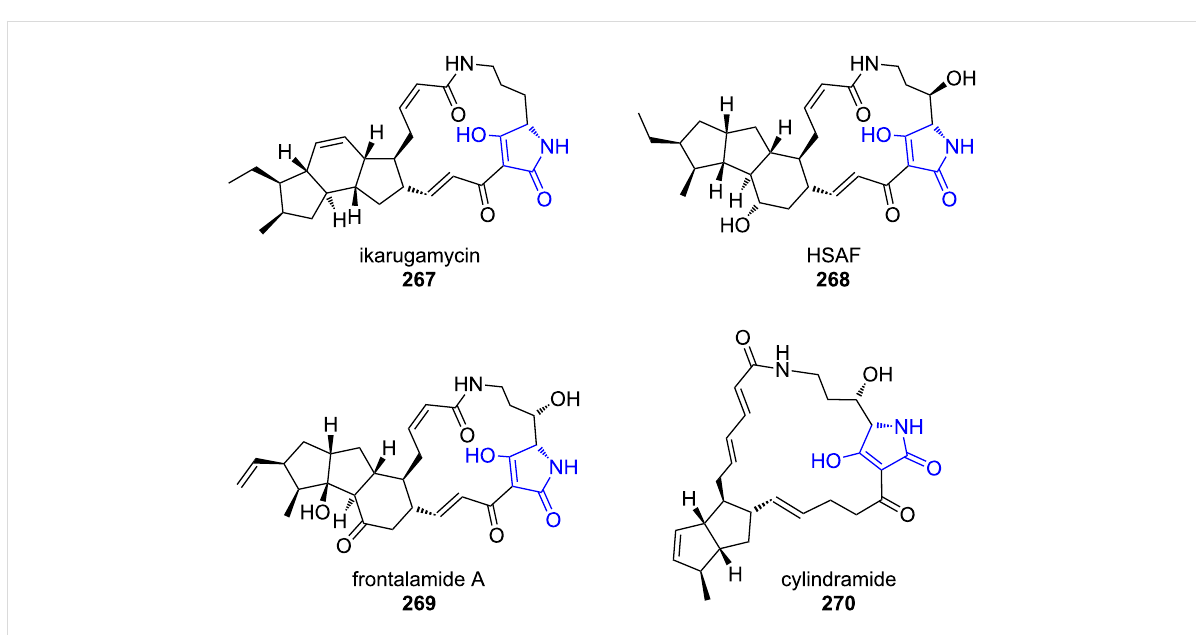
Figure 7: Representative examples of PTMs with varying ring sizes and oxidation patterns